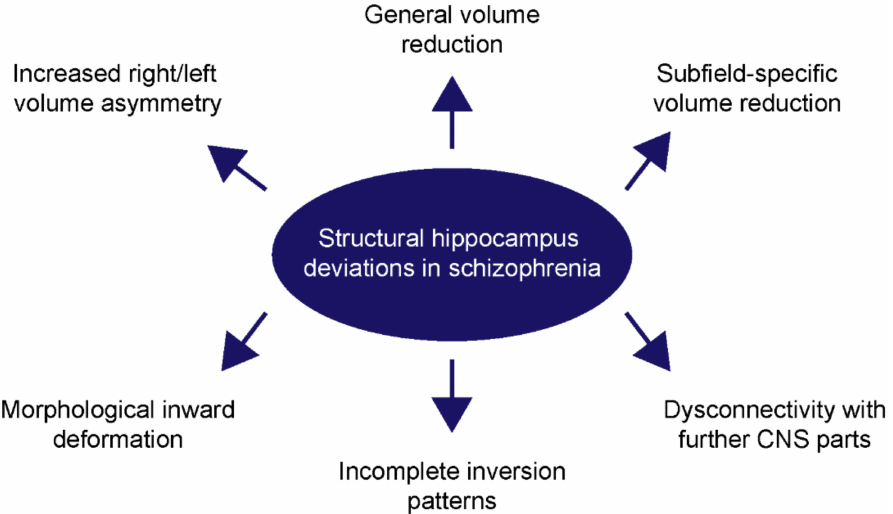
Figure 1. An overview of the most common structural hippocampus deviations in schizophrenia. Patients suffering from schizophrenia frequently develop a reduction of the general hippocampal volume, as well as a higher volume asymmetry between the left and right hippocampus. Furthermore, subfield-specific volume changes were especially described for the CA1- and CA2-region. Besides vol- ume reductions, morphological abnormalities are known and include incomplete inversion patterns and inward deformations. Lastly, connectivity studies unraveled an impaired connection between the hippocampus of schizophrenic patients with further parts of the